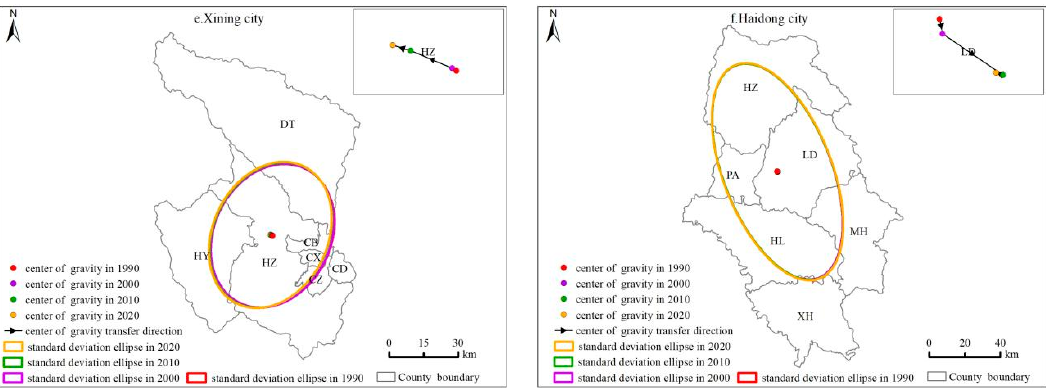
Figure 6. Distributions of central rural residential land shifts at the city level in the study area from 1990 to 2020.